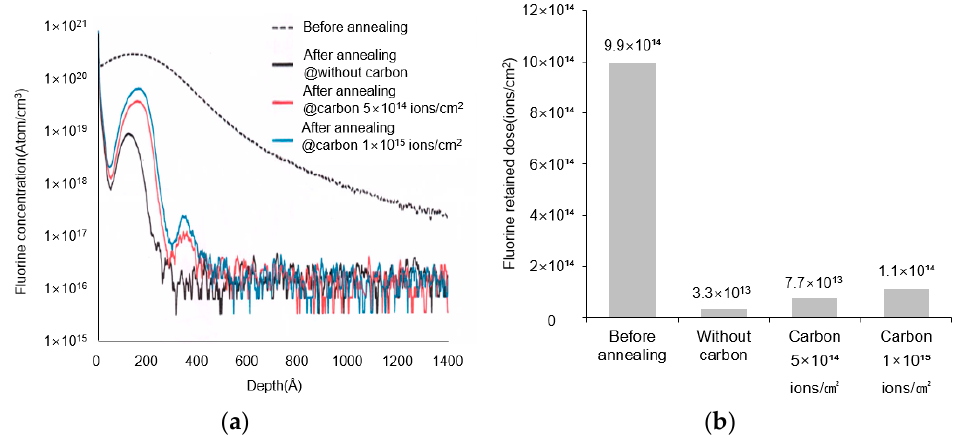
Figure 4. ( a ) SIMS profile of fluorine concentration remained in the wafer before and after the annealing. ( b ) Retained dose of fluorine in the wafer.